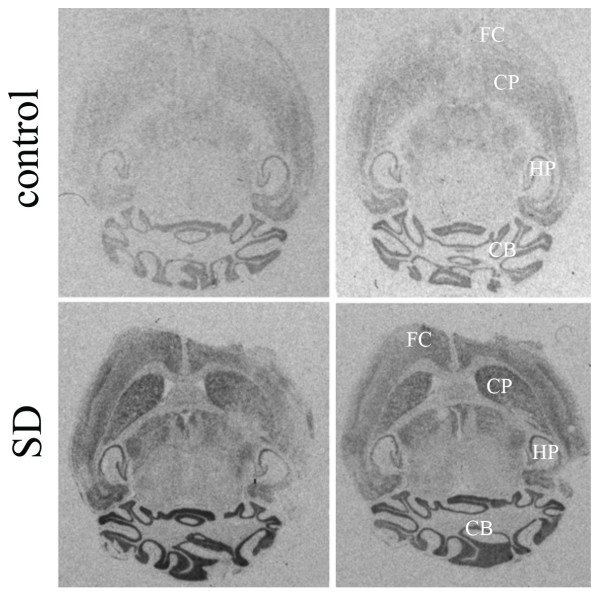
Representative in situ hybridizations for per1 expression in two horizontal brain sections from a sleep deprived (SD, lower panels) and a control (upper panels) mouse. Following 6 h SD per1 mRNA increased throughout the brain. This increase was especially pronounced in the cerebral cortex and cerebellum (CB), consistent with our qPCR data (Fig. 1). Note the very low cortical expression in control mice which, at ZT6, spent most of the preceding 6 h sleeping. Within the cortex, increases were especially notable in the frontal cortex (FC) and in and around the cingulate cortex. Caudate-Putamen (CP) and hippocampus (HP) are labeled for orientation.